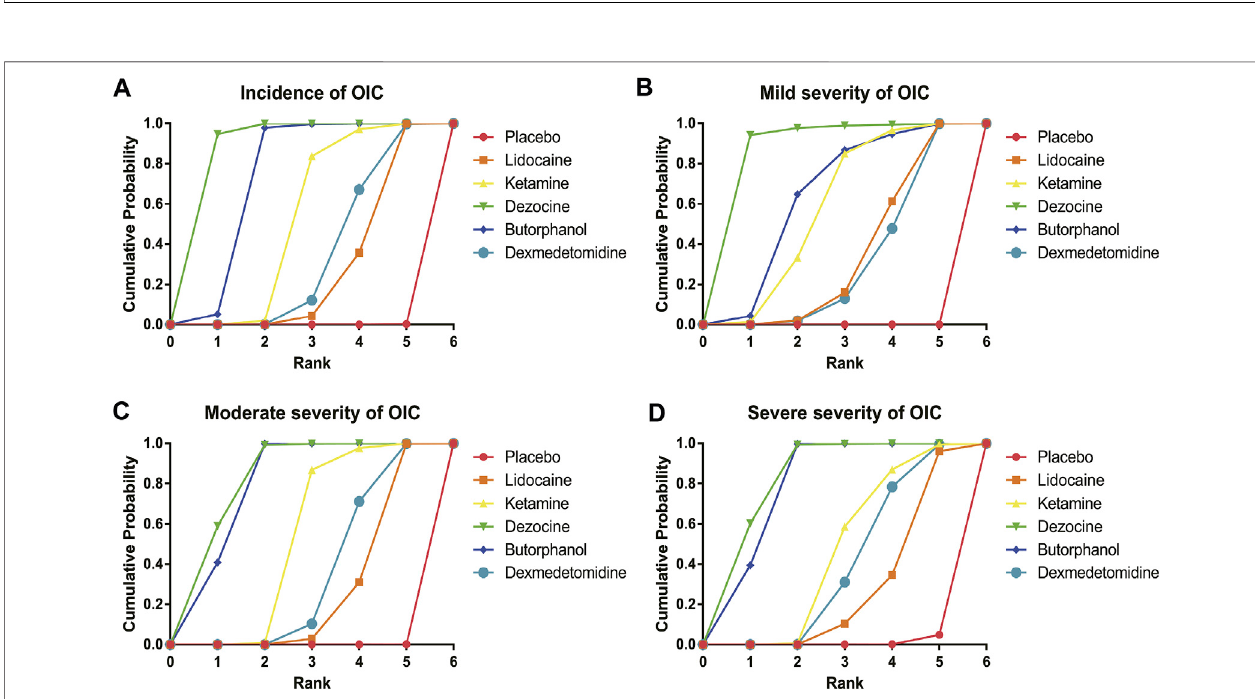
FIGURE7| Surfaceunderthecumulativerankingcurve(SUCRA) probabilities ofdifferentdrugsforfour clinicaloutcomes. (A) Incidence ofOIC; (B) Mildseverityof OIC; (C) Moderate severity of OIC; and (D) Severe severity of OIC.